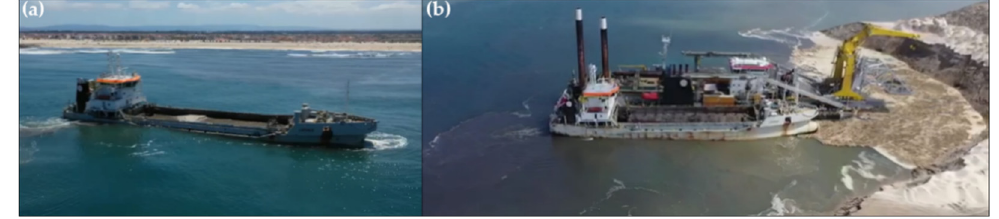
Figure 3. ( a ) Dumping area and ( b ) dredging